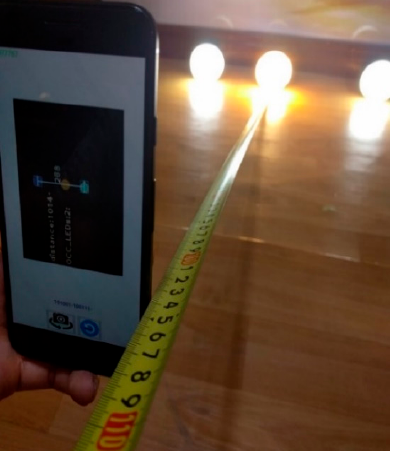
Figure 28. Distance estimation experiment.